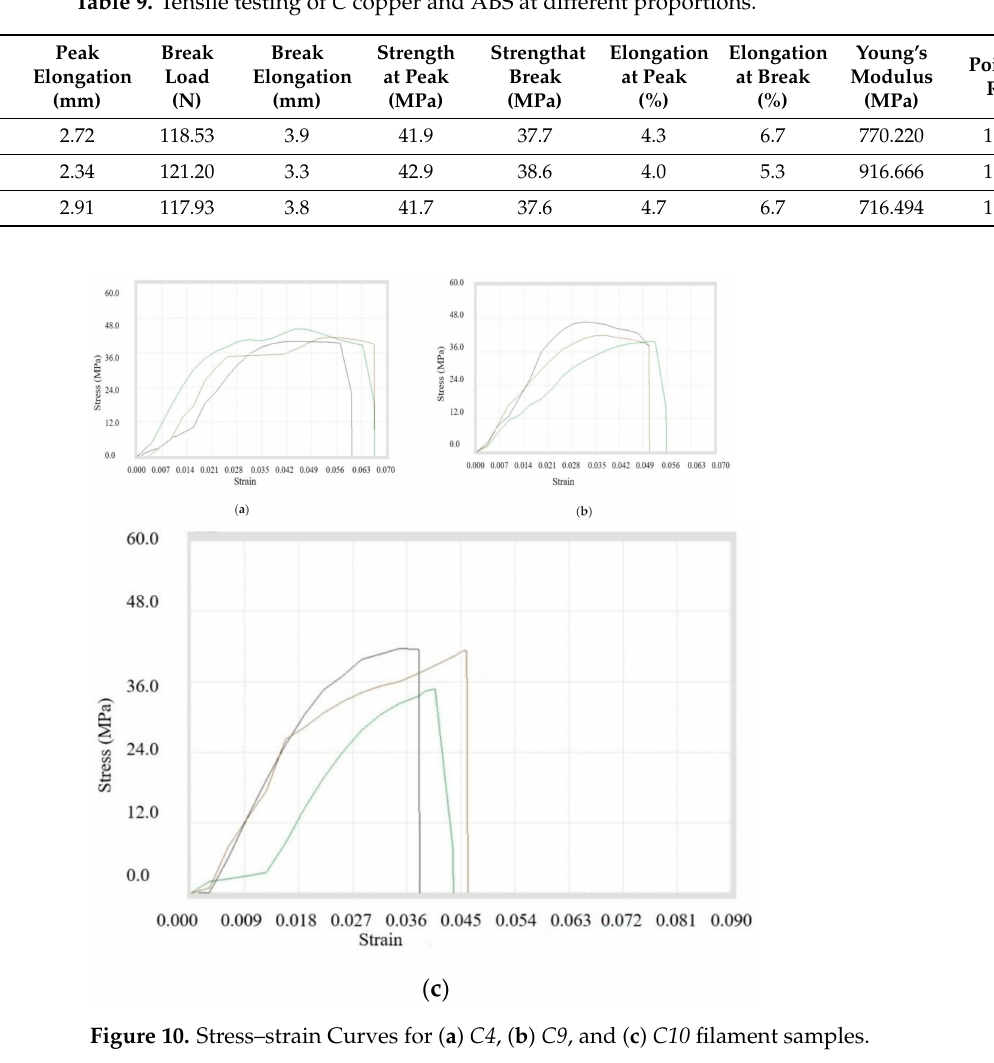
Table 9. Tensile testing of C copper and ABS at different proportions.